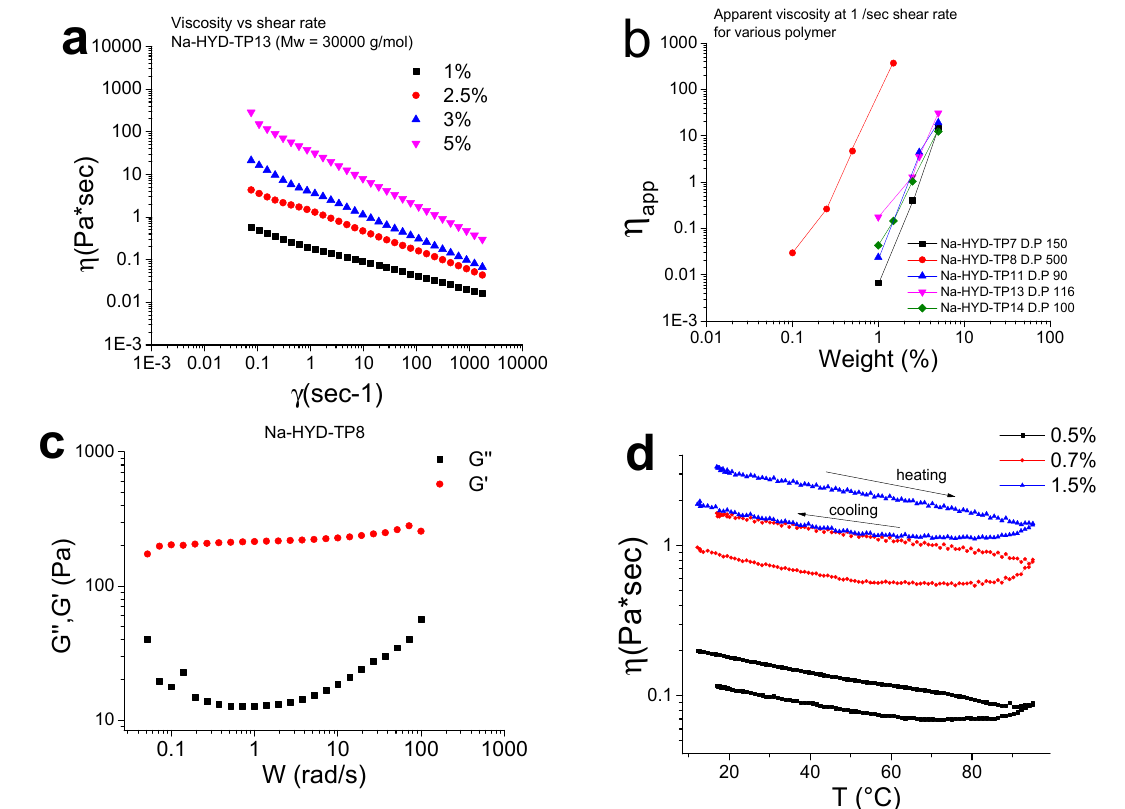
Figure 12. Shear viscosity measurements for various polymer: ( a ) Na-HYD-TP13 and ( b ) apparent viscosity taken at 1 sec − 1 for all analysed polymers; ( c ) oscillation frequency sweep for Na-HYD-TP8 and ( d ) viscosity dependence of temperature in range 20 ◦ C to 90 ◦ C for polymer NaHYD-TP8 at different weight concentration.